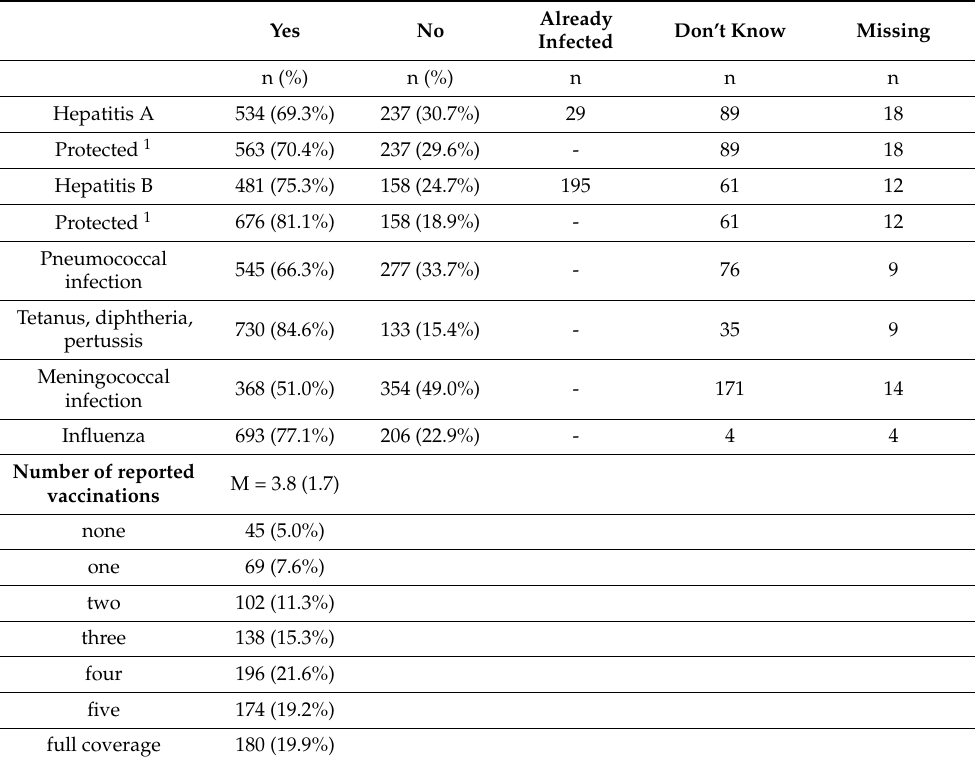
Table 2. Self-reported coverage of vaccinations among people aging with HIV in Germany (2013, n = 904).